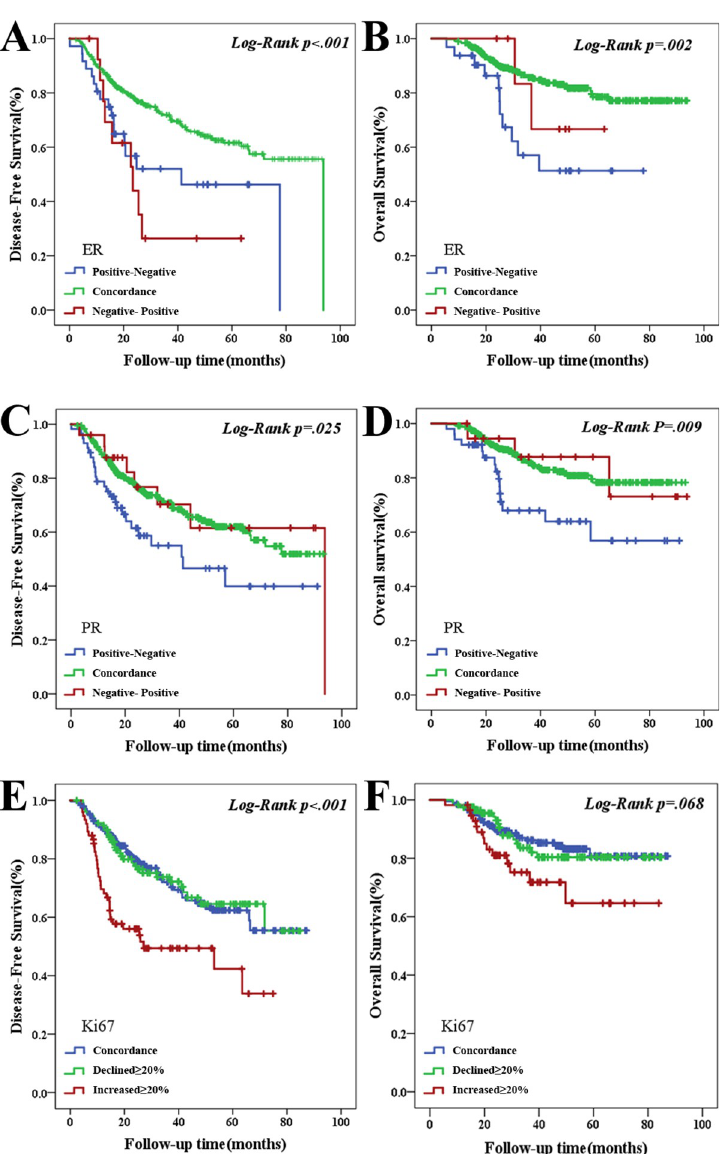
.009. (E) DFS for Ki-67 discordance, p < .001; (F) OS for Ki-67 discordance, p =